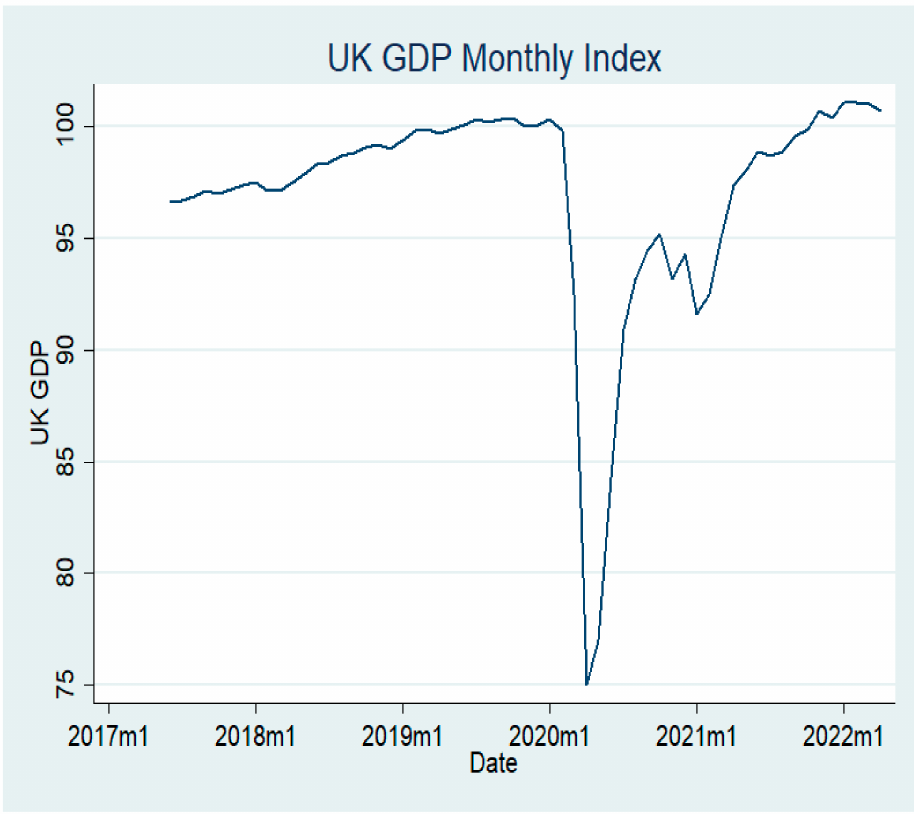
Figure 1. UK GDP, 2019 =